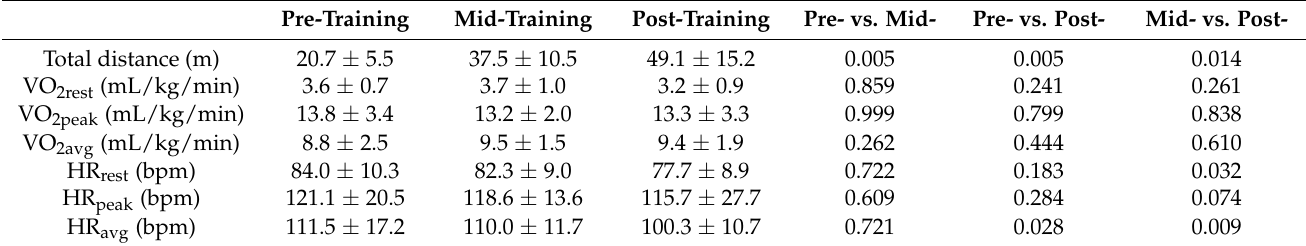
Table 2. Walking distance in the 6-min walk test and cardiorespiratory outcome measures.